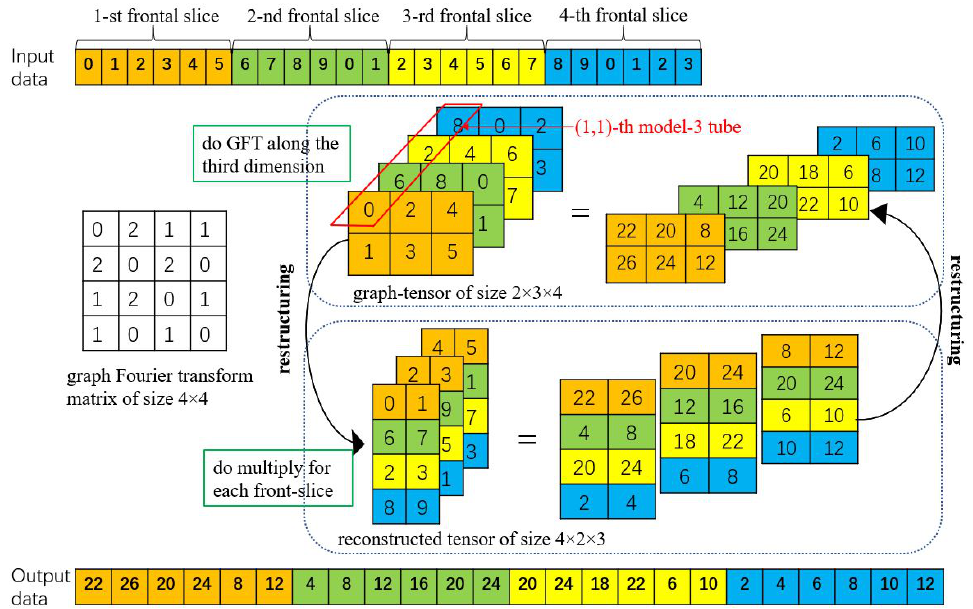
Figure 3. Reconstruction of graph-tensor data for computing graph Fourier transforms in the batched